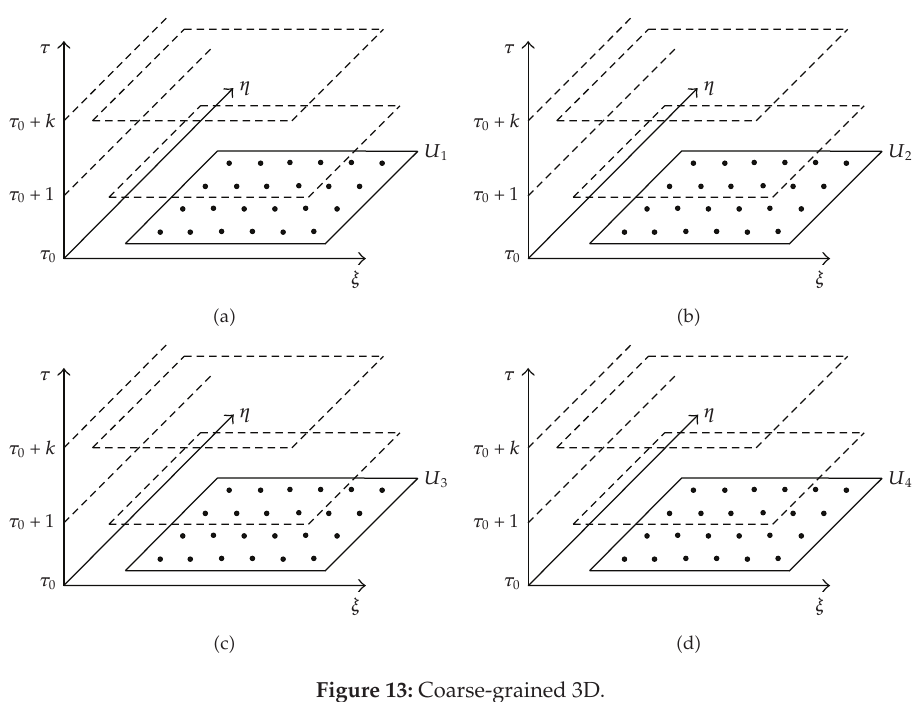
Figure 13: Coarse-grained